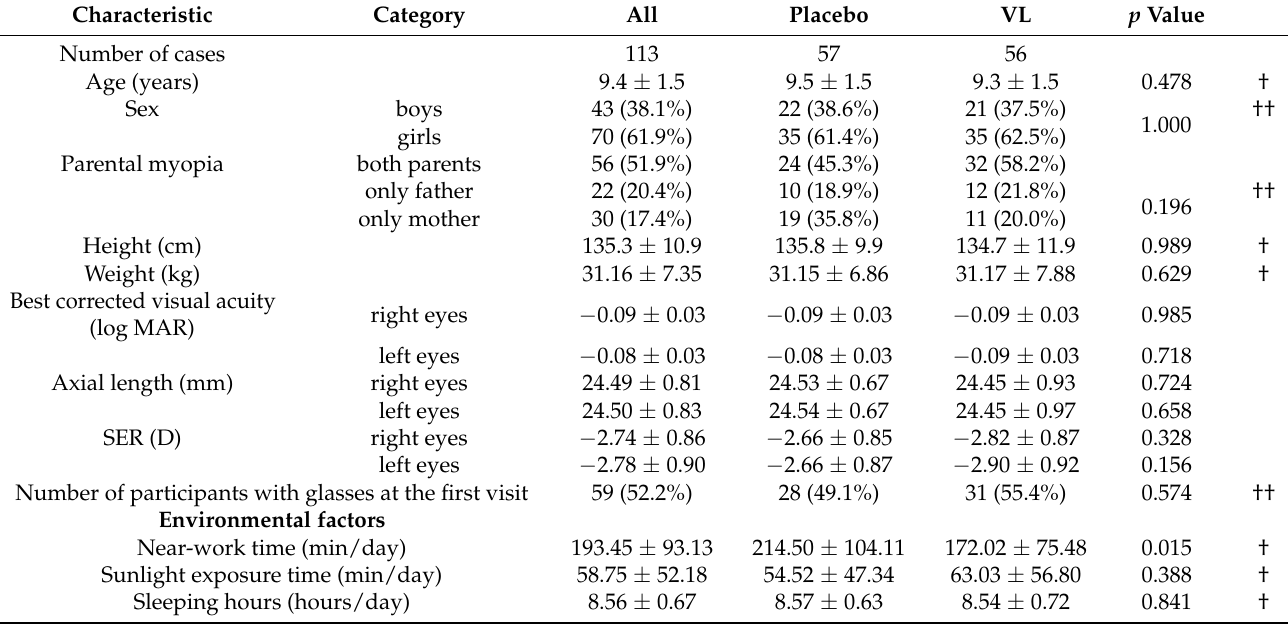
Table 1. Characteristics of the 113